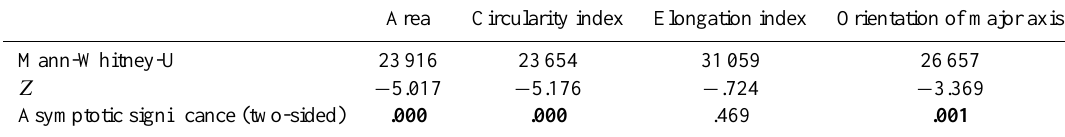
Table 4. Results of the rank-based Mann-Whitney-U test for morphometric differences between lakes on Yedoma uplands and lakes in basins . Significant differences between the two lake subgroups were found for area , circularity index , and orientation of major axis .